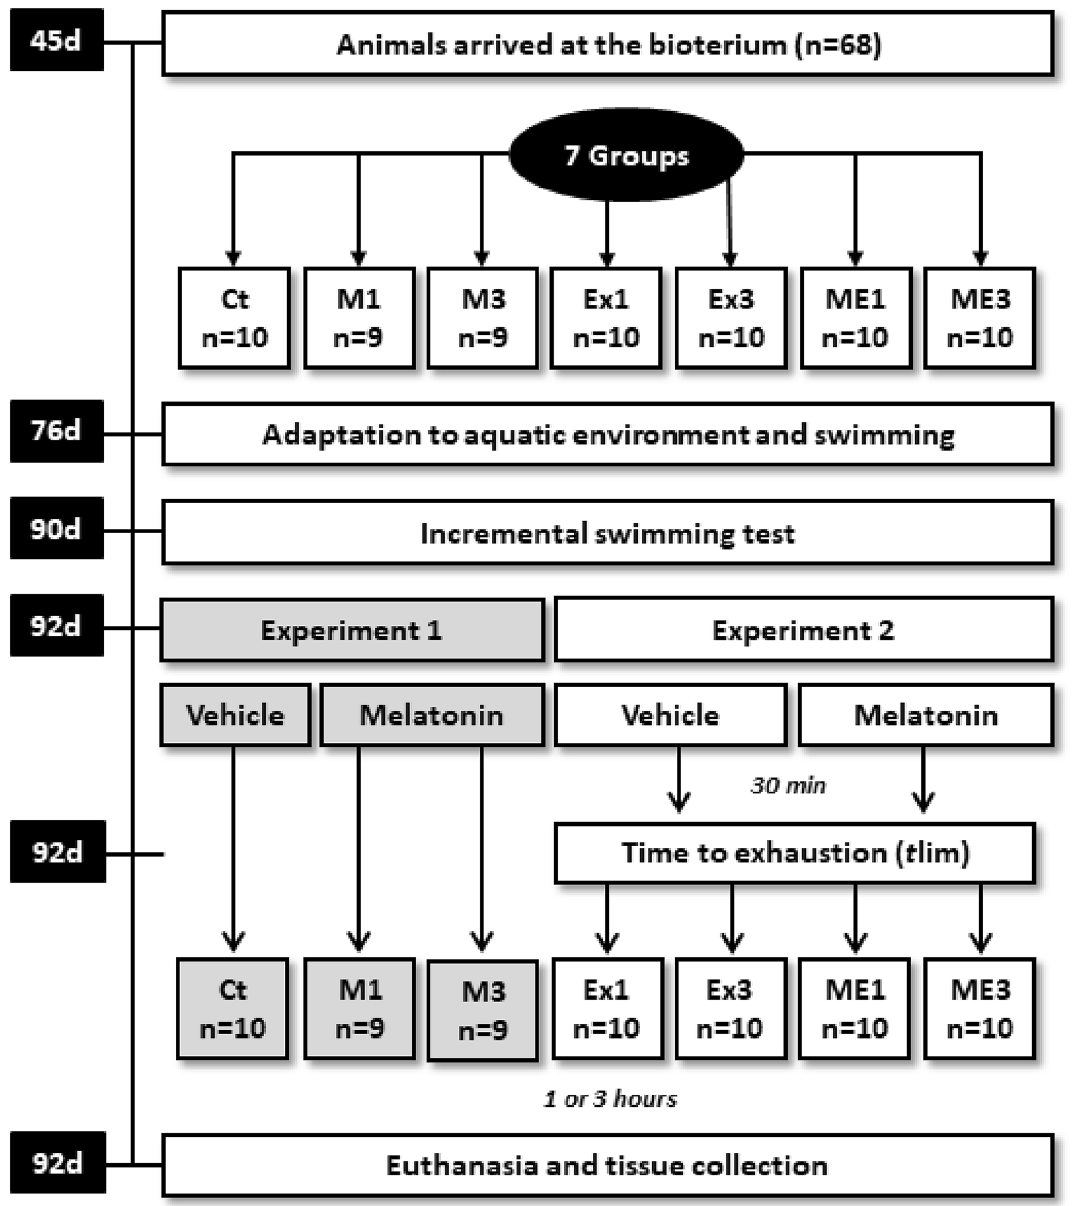
Figure 1. Chronological sequence of events that occurred during the experiments. Control group (Ct); rats treated with melatonin and euthanized 1 h (M1) or 3 h after the last procedures (M3); rats that exercised and were euthanized 1 h (Ex1) or 3 h after t lim (Ex3); rats that were treated with melatonin, exercised, and were euthanized 1 h (ME1) or 3 h after t lim (ME3). d: days; min: